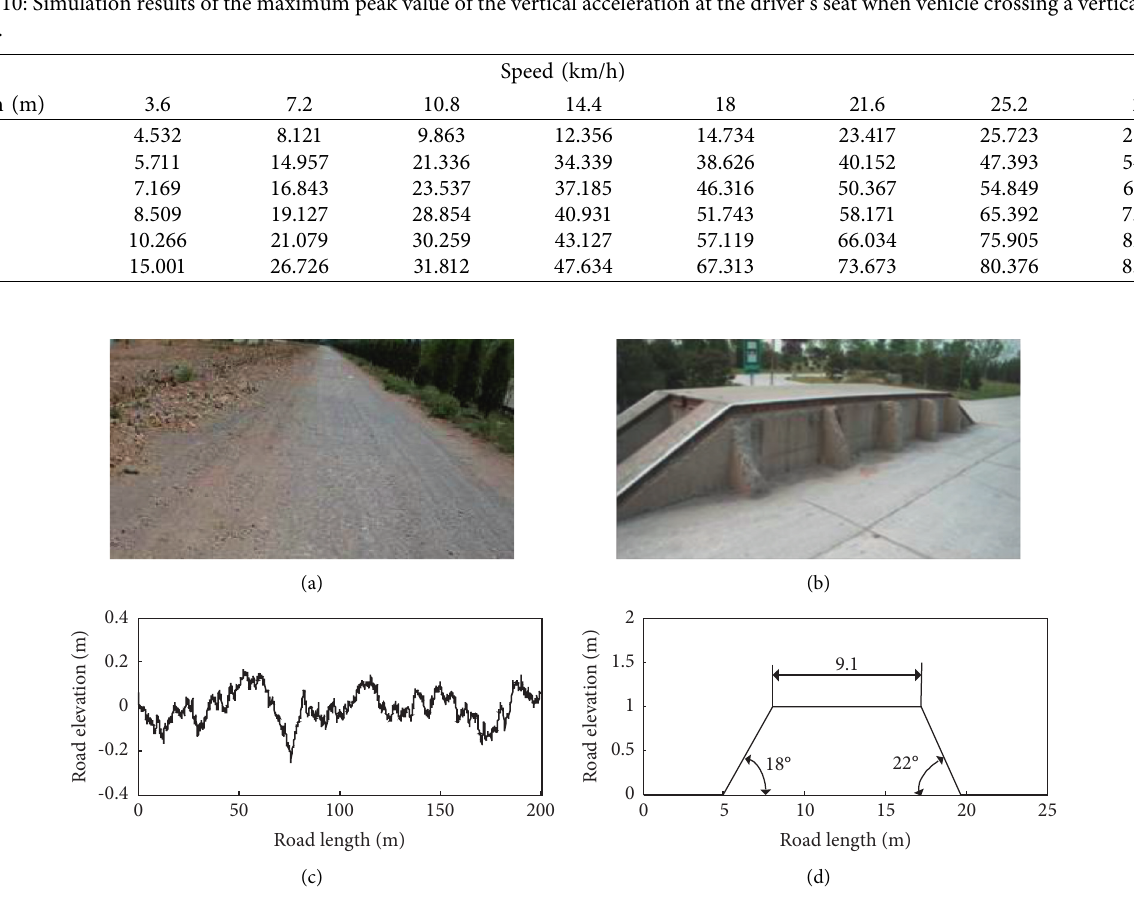
Figure 17: Typical experiment road. (a) Random uneven road. (b) Vehicle obstacle platform. (c) Uneven road curve. (d) Obstacle platform